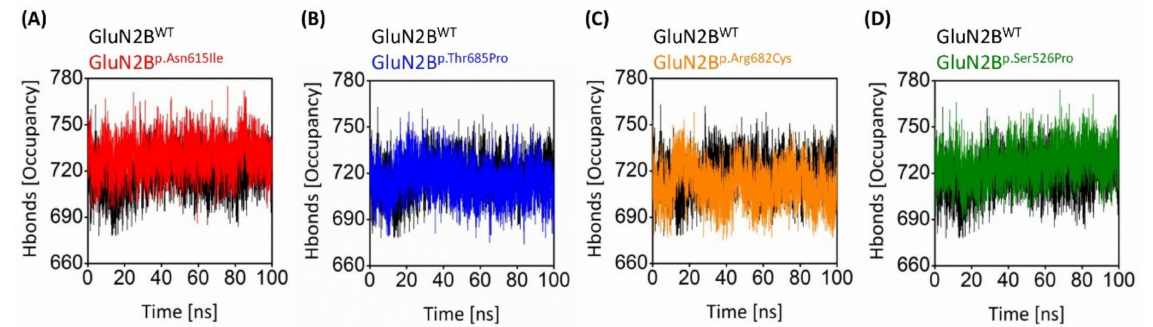
Figure 7. The number of hydrogen bonds in the three-dimensional structure displayed versus the amount of time spent running the simulation. The GluN2B WT is shown in comparison with ( A ) GluN2B p.Asn615Ile , ( B ) GluN2B p.Thr685Pro , ( C ) GluN2B p.Arg682Cys , and ( D ) GluN2B p.Ser526Pro